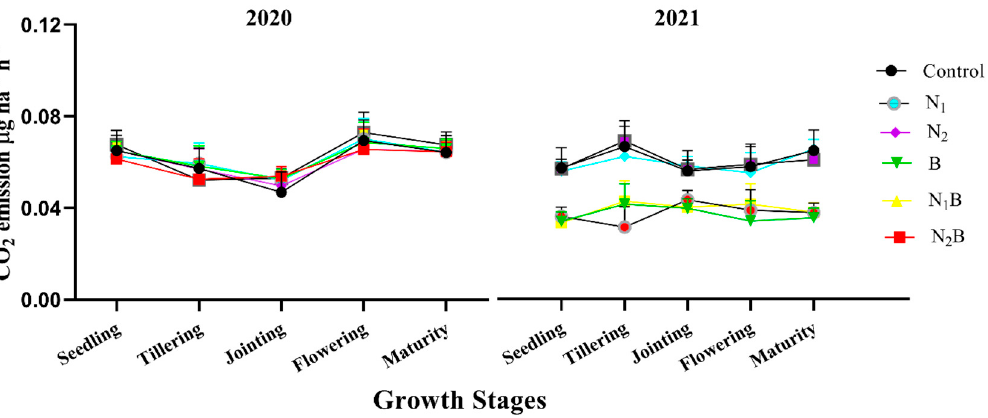
Figure 2. Direct effect of biochar on CO 2 emissions at different growth stages of spring barley (2020) and after effects on pea crop (2021). Treatments: control-without amendments; N 1 -160 kg ha − 1 nitrogen fertilizer; N 2 -120 kg ha − 1 nitrogen fertilizer; B-25 t ha − 1 biochar; N 1 B-160 kg ha − 1 nitrogen fertilizer plus 25 t ha − 1 biochar; N 2 B-120 kg ha − 1 nitrogen fertilizer plus 25 t ha − 1 biochar.